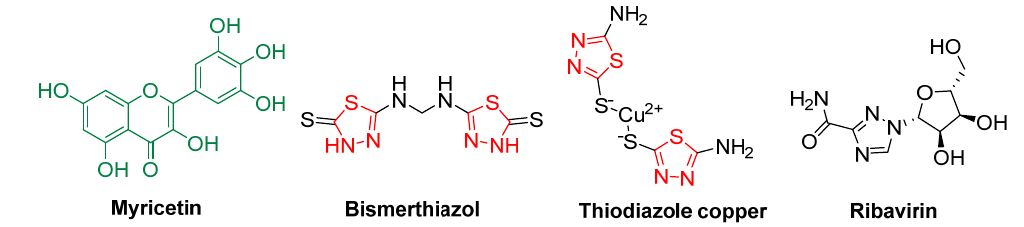
Figure 1. The structures of myricetin and selected commercial drugs.